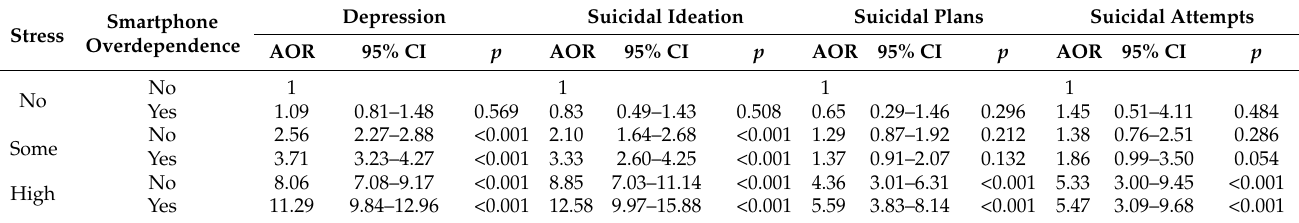
Table 4. Combined effects of smartphone overdependence and stress on depression, suicidal ideation, suicidal plans, and suicidal